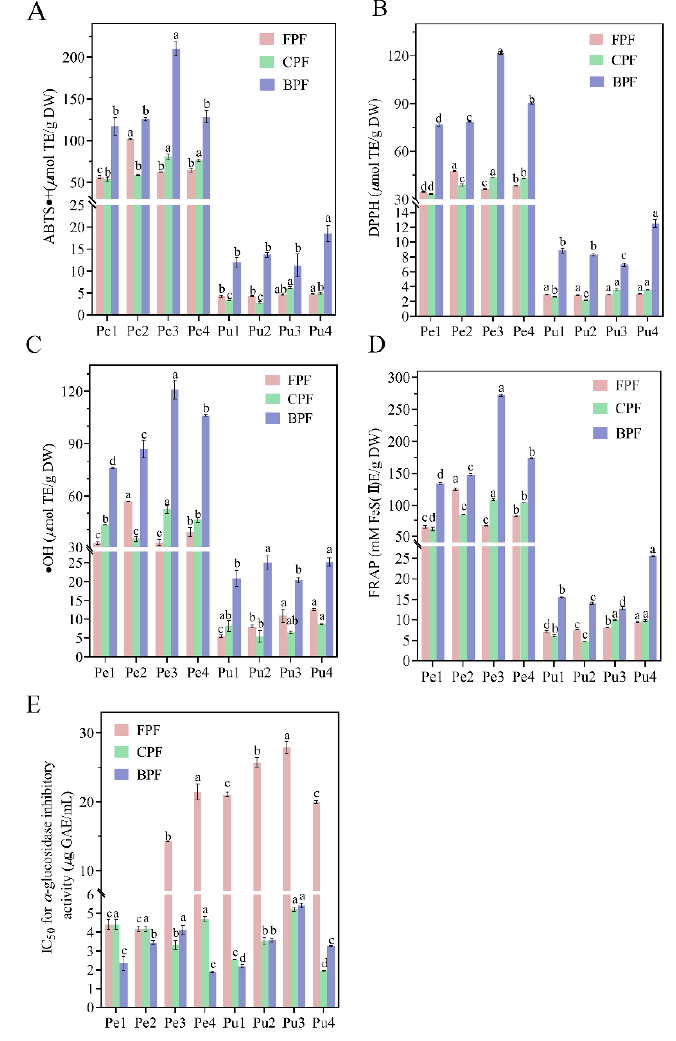
Figure 3. ABTS · + levels ( A ), DPPH values ( B ), · OH levels( C ), FRAP values ( D ), and IC 50 values of α -glucosidase inhibitory activities ( E ) of free, conjugated, and bound phenolic fractions in the peel and pulp of different wampee samples from South China. Different letters (a–d) indicate significant differences among free, conjugated, and bound phenolic fractions of wampee peel/pulp samples. Pe, wampee peel; Pu, wampee pulp; FPF, free phenolic fraction; CPF, conjugated phenolic fraction; BPF, bound phenolic fraction.